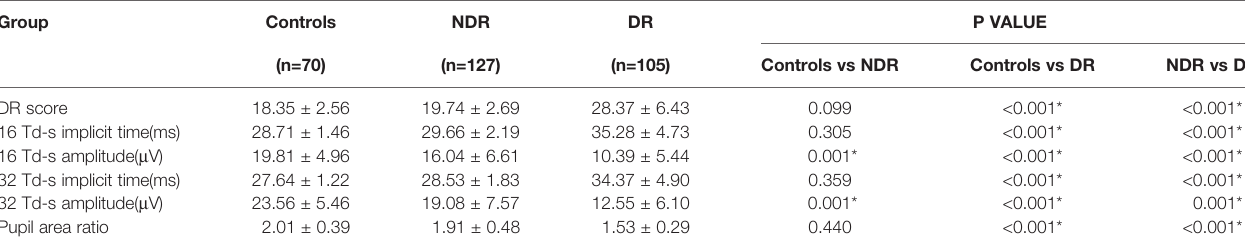
TABLE 2 | Parameters of the DR risk assessment protocol.